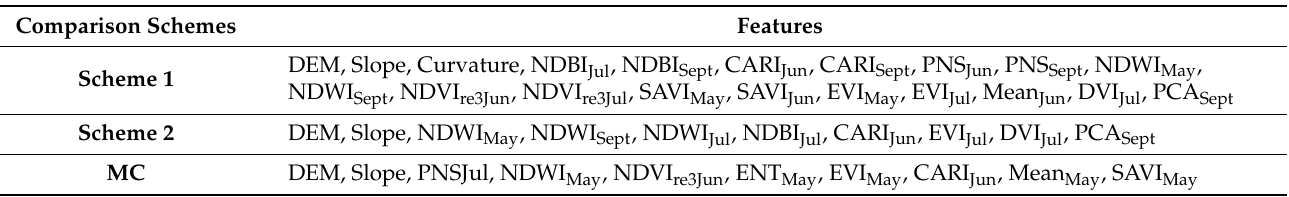
Table 7. Comparison of different feature-selection